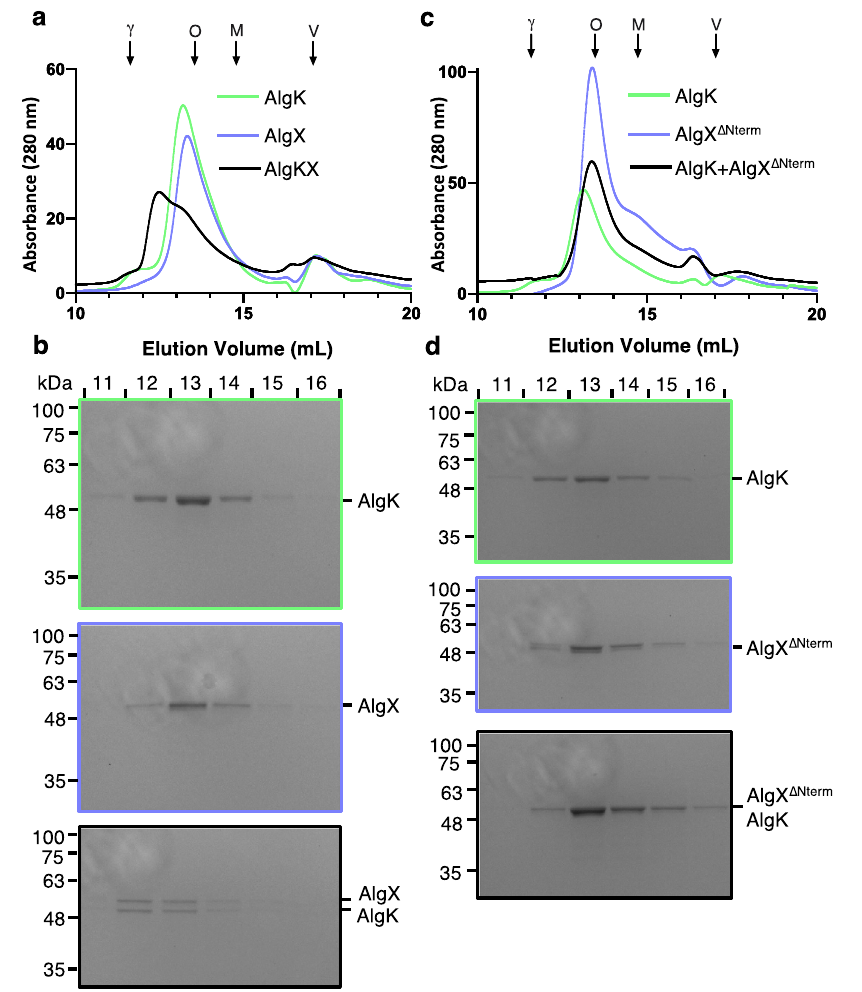
Fig. 2 | The N-terminus of AlgX is required for interaction with AlgK. a Gel the two added together (black) overlaid. This experiment was repeated indepen- fi ltration chromatograms of AlgK dentlyoneothertime. d Coomassie-stainedSDS-polyacrylamidegelcorresponding Pp (light green), AlgX Pp (periwinkle), and the AlgKX Pp complex (black) overlaid. This experiment was repeated independently to the indicated fractions (top) from the experiments in panel c . Gel images are one other time. b Coomassie-stained SDS-polyacrylamide gels corresponding to outlined using the same color scheme as in panel c . This experiment was not the indicated fractions (top) from the experiments in panel a . Gel images are out- repeated. Molecular weight standards are indicated by the arrows: γ γ -globulin, O linedusingthesamecolorschemeasinpanel a .Thisexperimentwasnotrepeated. ovalbumin,Mmyoglobin,andVvitaminB12withmolecularweights158,44,17,and c Gel fi ltrationchromatogramsofAlgK Pp (lightgreen),AlgX Pp Δ Nterm (periwinkle),and 1.35kDa, respectively. Source data are provided as a Source Data fi